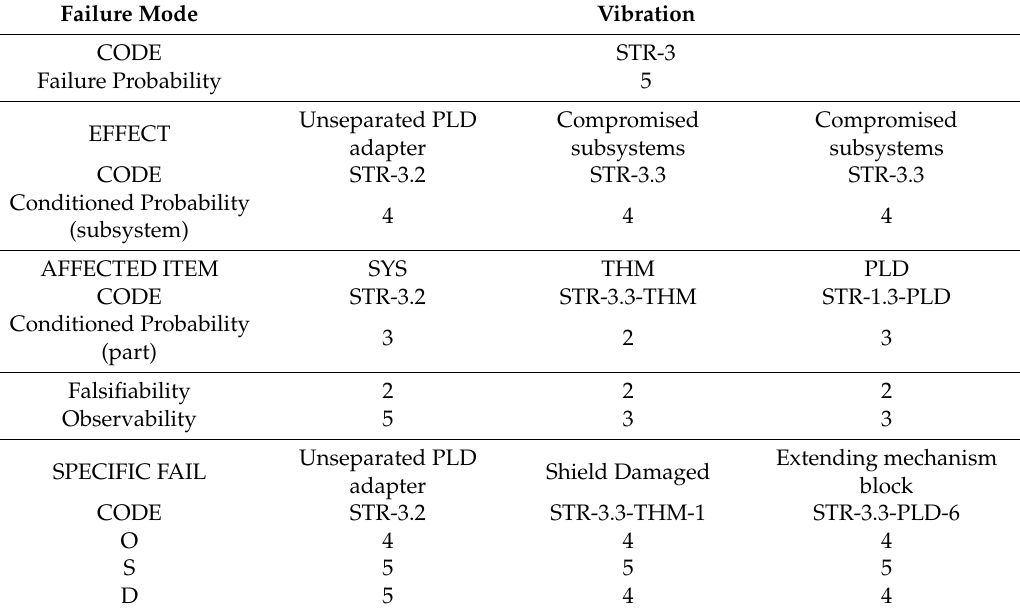
Table 15. Examples of criticality analysis for STR “Vibration” failure mode